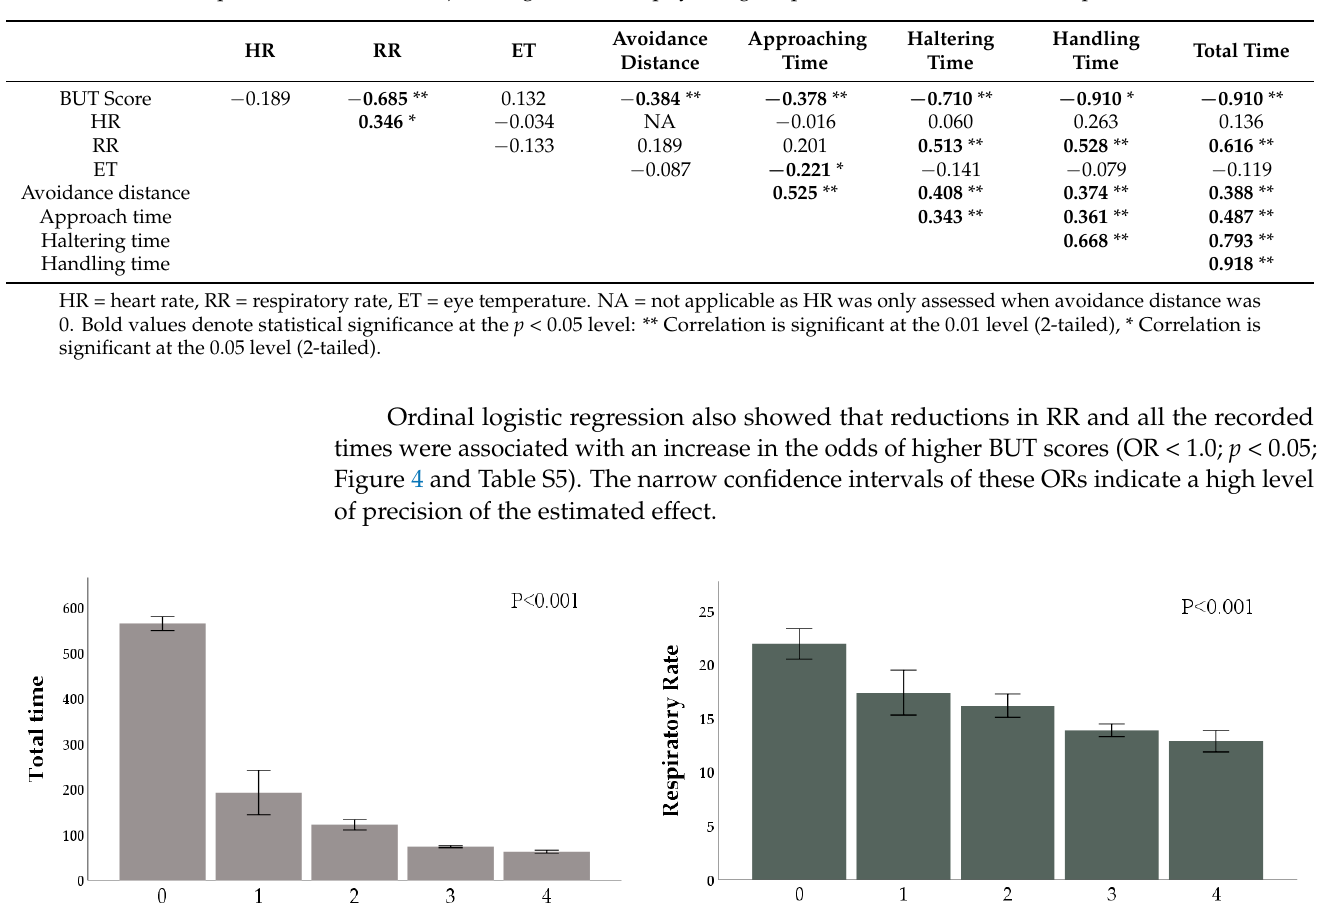
Table 7. Spearman correlations ( (cid:36) ) among BUT score, physiological parameters, and behavioural parameters.